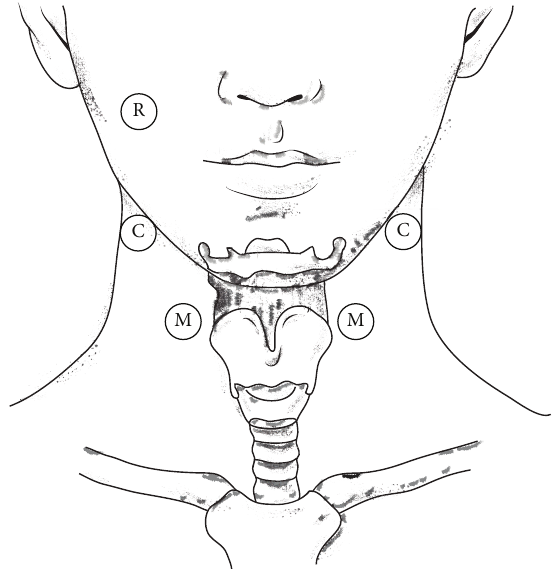
Figure1:Electrodepositioning.R=referenceelectrode,M=voltage measurement electrodes, and C = current source